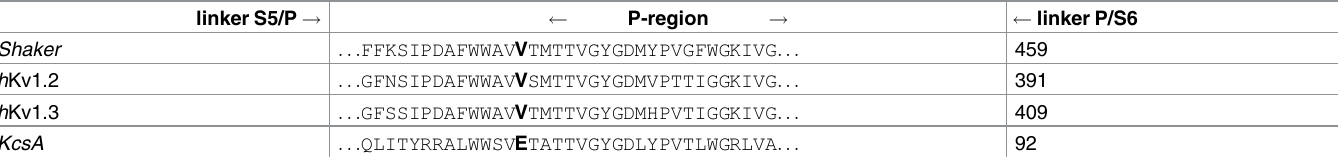
Table 1. Sequence alignment of the different channels. The highlightedamino acid was mutated in h Kv1.2 and h Kv1.3 and correspond to position 438 in Shaker , 370 in h Kv1.2, 388 in h Kv1.3 and 71 in KcsA . linker S5/P ! P-region ! linker P/S6